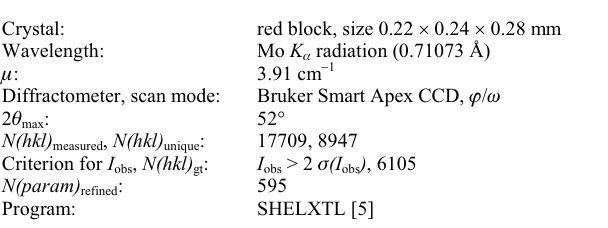
Table 1. Data collection and handling.